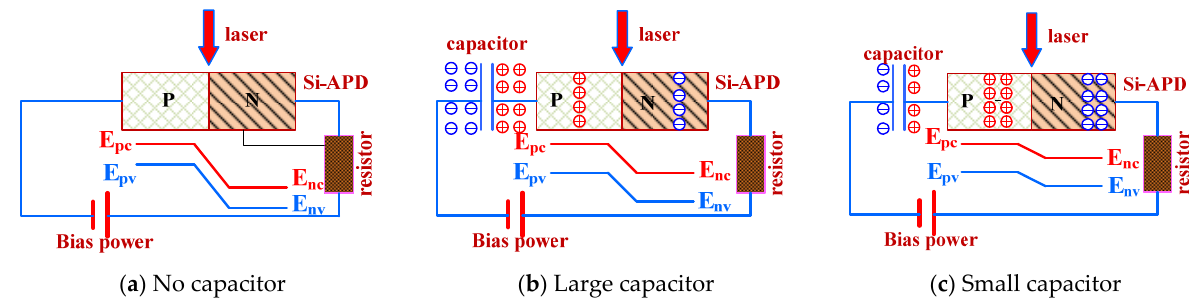
Figure 4. The internal mechanism for the influence of different external capacitances on the maximum temperature rise on Si ‐ APD surfaces.